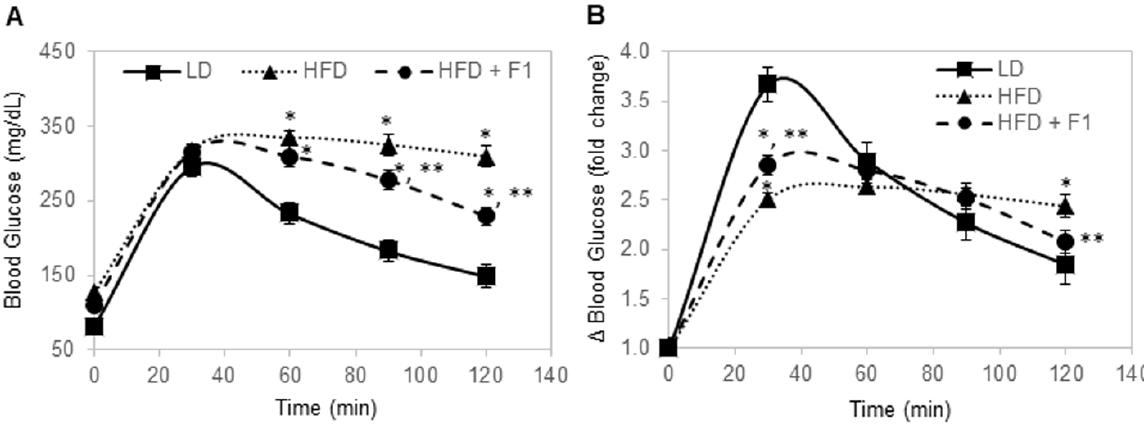
Figure 10. F1 composition improves glucose tolerance in diet-induced obesity mice. ( A ) Blood glucose level as a function of time post-injection. ( B ) Fold change in blood glucose level as a function of time post-injection. Error bars are the standard deviations of forty mice per animal group. Single and double asterisks indicate a statistical significance of a p -value ≤0.01 versus the LD and HFD animal groups, respectively.